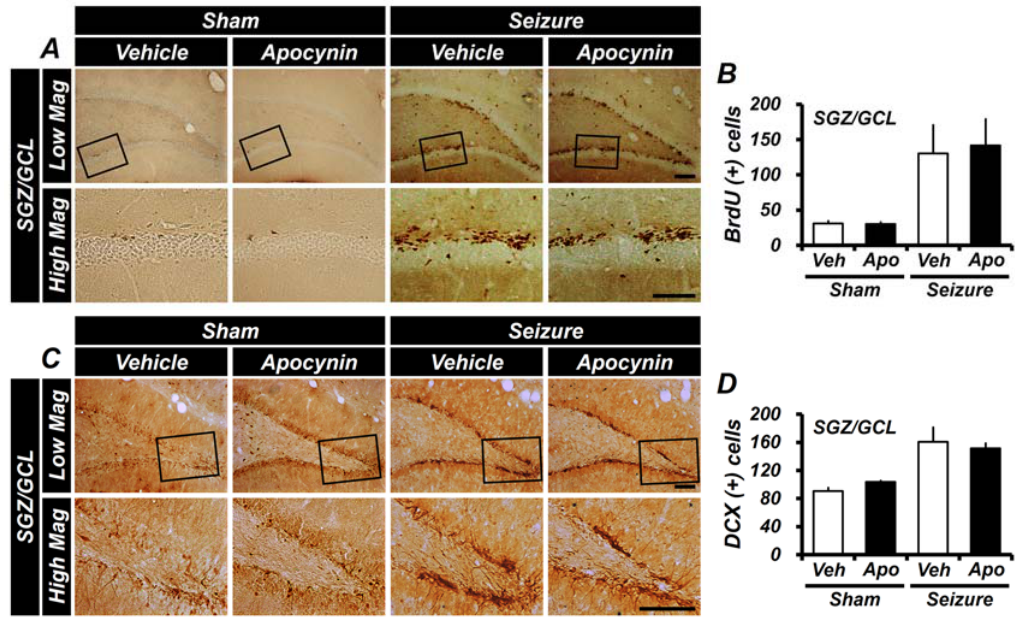
Figure 3. Treatment with apocynin for one week does not affect cell proliferation and neuroblast production after seizures. ( A ) Representative immunohistochemical staining with 5-bromo-2 ′ - deoxyuridine (BrdU) in the subgranular zone (SGZ) of dentate gyrus (DG). A cluster of proliferation cells labeled with BrdU in the SGZ immediately following a seizure is shown. BrdU + cells are increased in the SGZ of the DG both in the vehicle group and in the apocynin group after 1 week of seizures. Boxed areas are higher magnification (bottom row). Scale bar = 100 μ m. ( B ) The bar graph shows the quantification of BrdU + cells from the SGZ of the DG. The seizure group, compared with the sham group, showed a greater increase in BrdU + cells. There was no significant difference between the seizure-vehicle- and apocynin-treated groups. ( C ) This figure shows the doublecortin (DCX)- immunoreactive cells in the SGZ of the DG and shows the neuroblast production by enlarging the DG and box area. In the DG of the hippocampal area where a seizure was induced by pilocarpine, more neuroblasts were observed than the uninjured hippocampus. Boxed areas are higher magnification (bottom row). Scale bar = 100 μ m. ( D ) The bar graph is the result of counting DCX + cells stained in the DG of the hippocampus. DCX + cells increased more in seizure-induced rats compared with the sham group. There was no significant difference between the vehicle- and apocynin-treated groups.